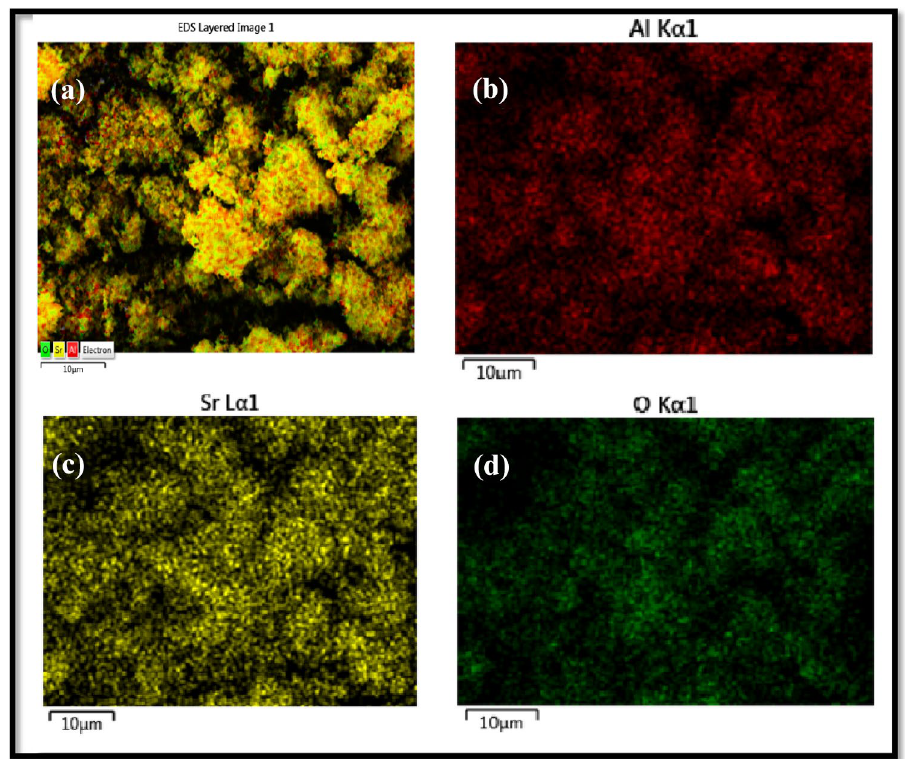
Figure 6. ( a – d ) Typical elemental mapping images forpure Sr 1−x Al 2 O 4 :Eu x (x = 0.00) phosphor (SAE